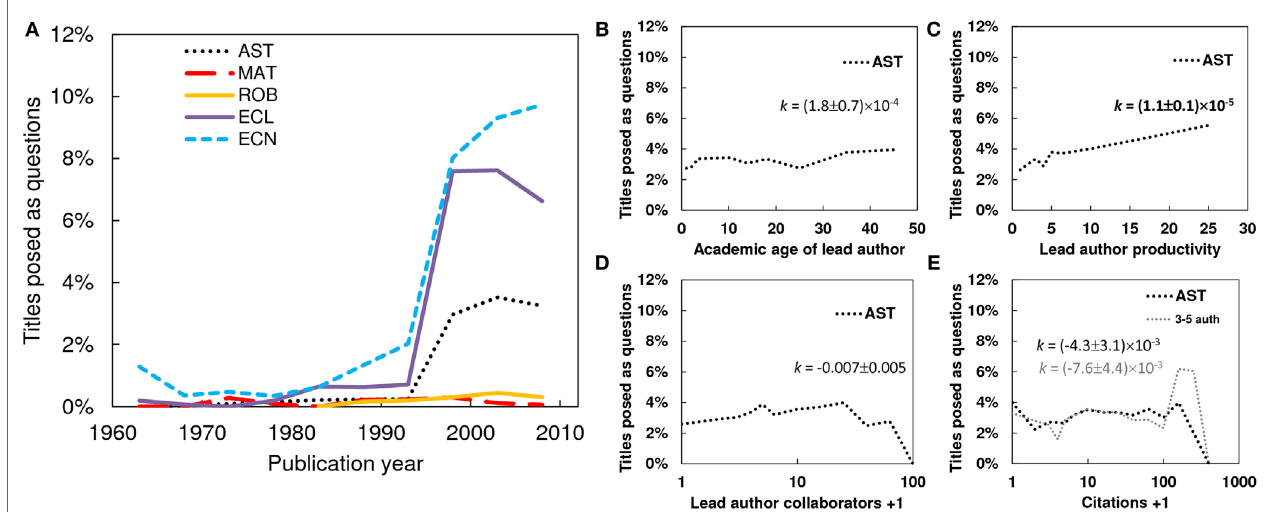
FigUre 3 | Trends involving interrogatory titles . (a) Percentage of interrogatory titles for five disciplines [astronomy (AST), mathematics (MAT), robotics (ROB), ecology (ECL), and economics (ECN)] from 1961 to 2010. Percentage of interrogatory titles for authors of different academic age (b) , productivity (c) , collaboration level (D) , and papers of different impact level (e)